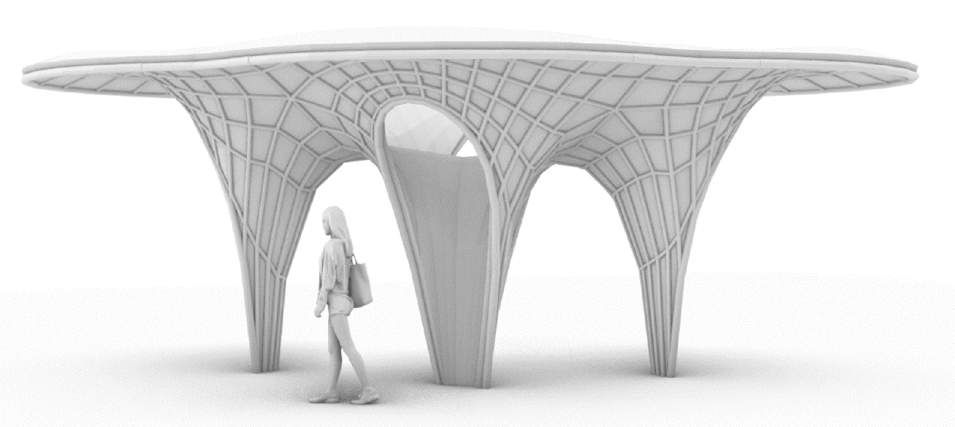
Figure 16. Architectural